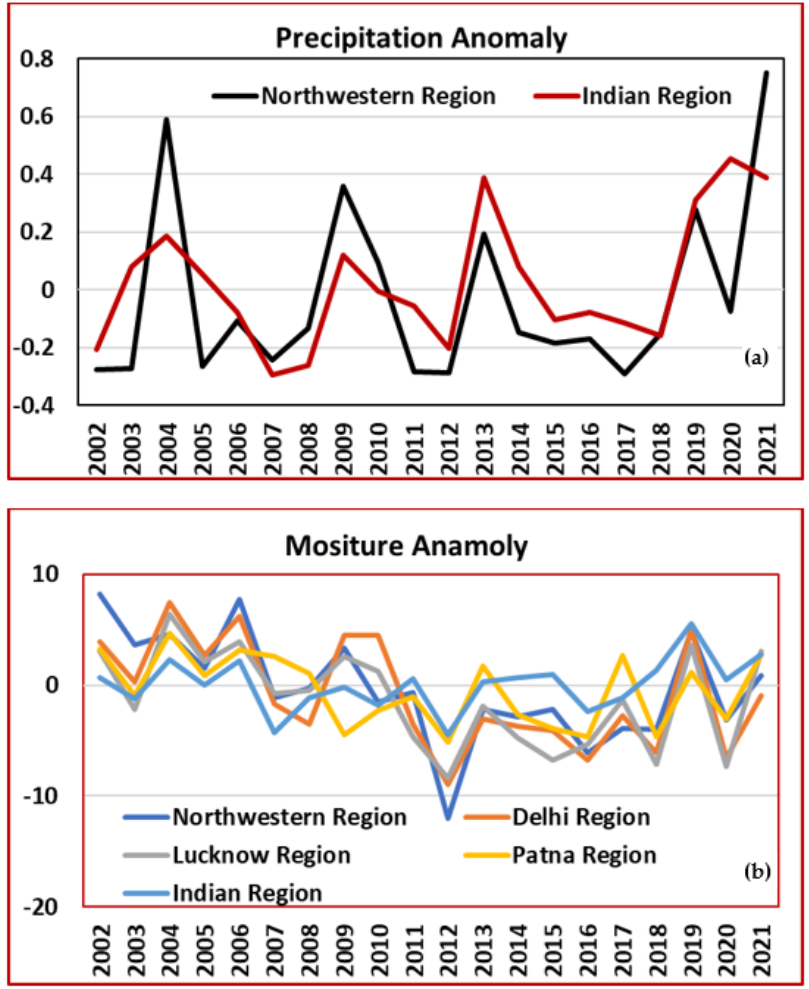
Figure 7. Averaged variables over selected regions of IGP for October and November from 2002 to 2021 ( a ) Rainfall anomaly (mm/day) ( b ) Moisture anomaly